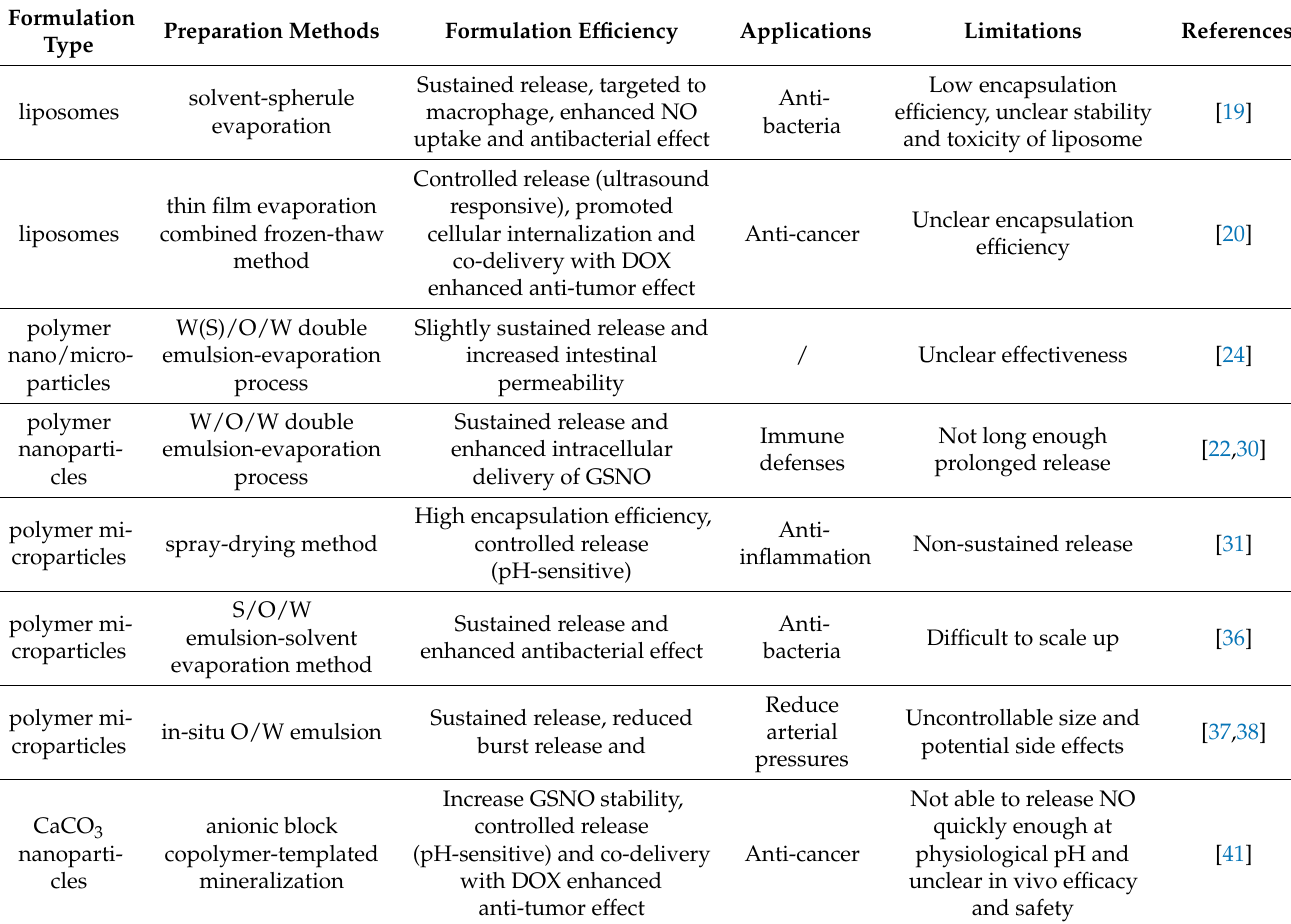
Table 1. Lists of direct GSNO loaded nano/micro-formulations without